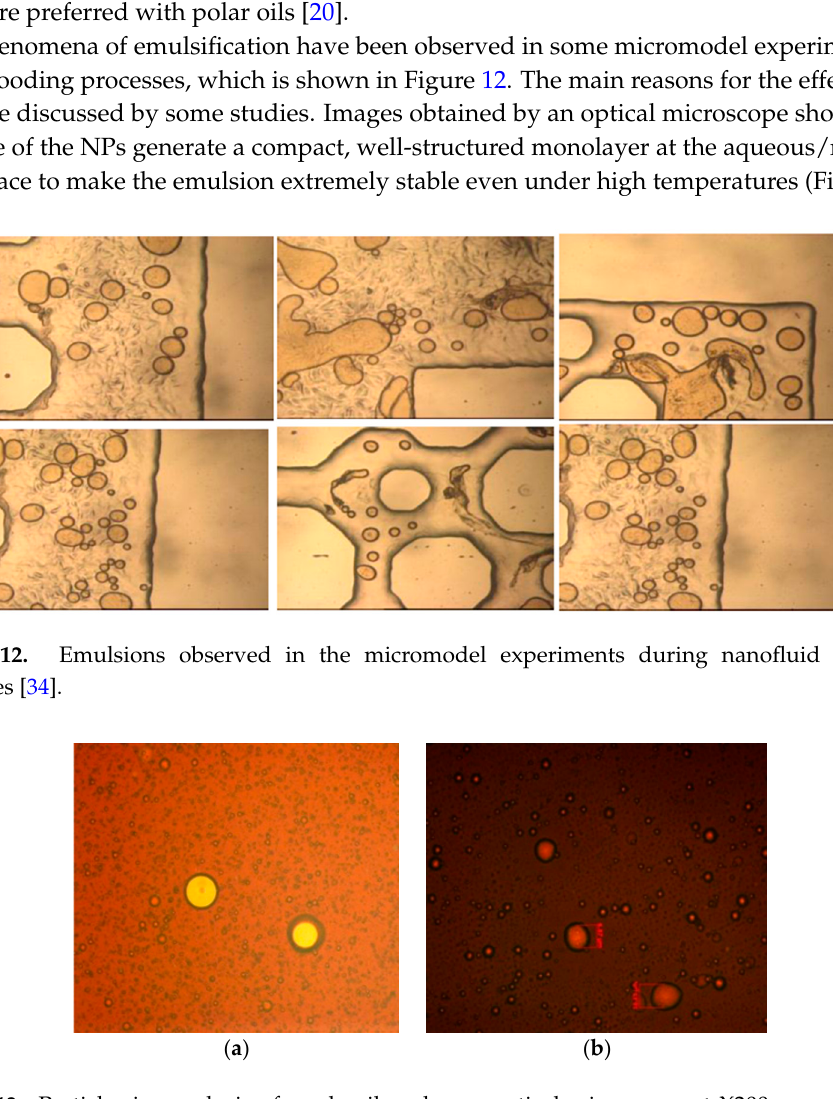
Figure 13. Particle size analysis of crude oil under an optical microscope at X200 magnification: ( a ) mixed with 30,000 ppm saline water; ( b ) mixed with the Al 2 O 3 nanofluid [ 16 ].